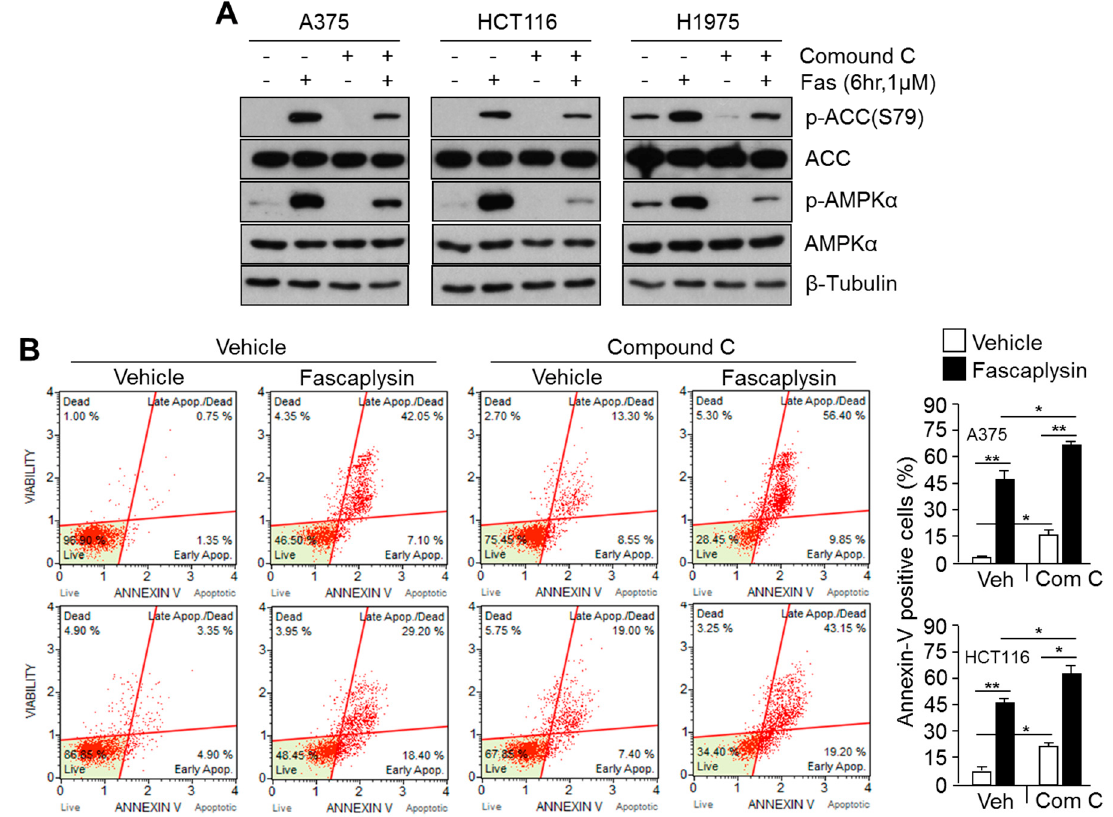
Figure 4. Suppression of fascaplysin-induced AMPK activation enhances the anti-cancer effect of fascaplysin. ( A ) A375, HCT116, and H1975 cells were pre-incubated with 5 μ M of compound C for 10 min, and were then further treated with 1 μ M of fascaplysin for 6 h. The protein levels were measured by Western blotting. ( B ) Compound C (5 μ M) pre-treated A375 or HCT116 cells were further incubated with fascaplysin (1 µ M) for 24 h, and then apoptotic cell numbers were measured using a Muse™ Annexin-V assay kit and a Mini Flow Cytometry Muse™ Cell Analyzer. Values are represented as the mean ± standard deviation (SD) of three independent experiments performed in duplicate; * p < 0.05 and ** p < 0.01.